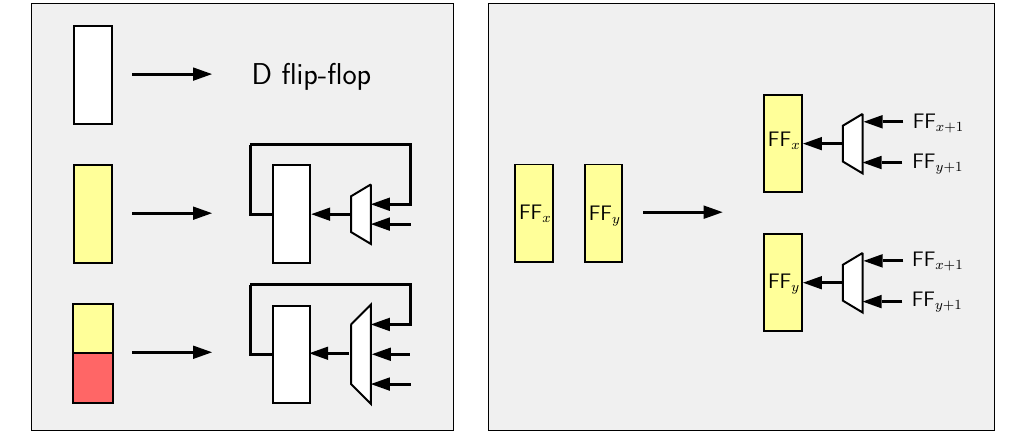
Figure 1: The color legend for interpreting circuit figures. White boxes denote a regular D flip-flop, a single-colored box is used for 2-input scan flip-flop and an n -color flip-flop denotes an ( n + 1)-input flip-flop. Two boxes that share a color mean that they are interconnected and therefore they can swap their input